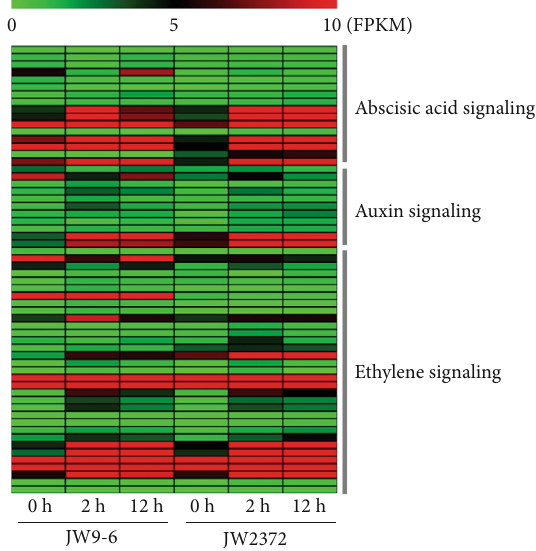
Figure 3: The heat map of DEGs related to plant hormone signaling pathways. Only DEGs related to ABA, auxin, and ethylene signaling pathways are shown. Each line refers to one gene. The color bar represents the FPKM